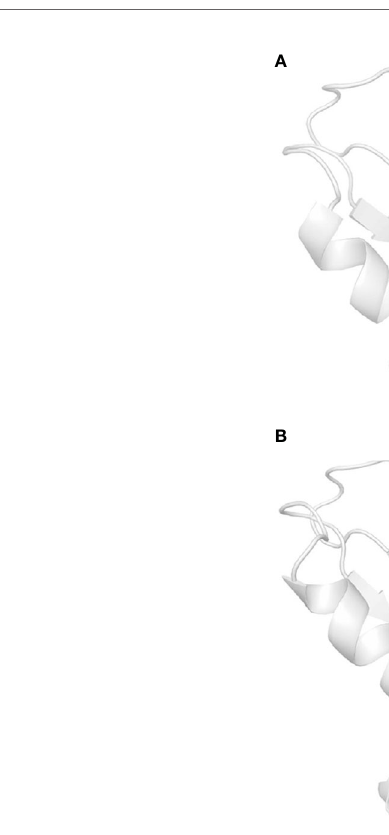
FIGURE 4 | Protein-ligand docking models. Docking structure of (A) berberine, and (B) antibiotics. All antibiotics are close to the proximal multidrug binding site (F-loop, red frame; G-loop, black frame) of AdeB. Berberine, pink; tigecycline, green; cipro fl oxacin, cyan; sulbactam, yellow; tetracycline, light salmon; meropenem, dark blue; amikacin,